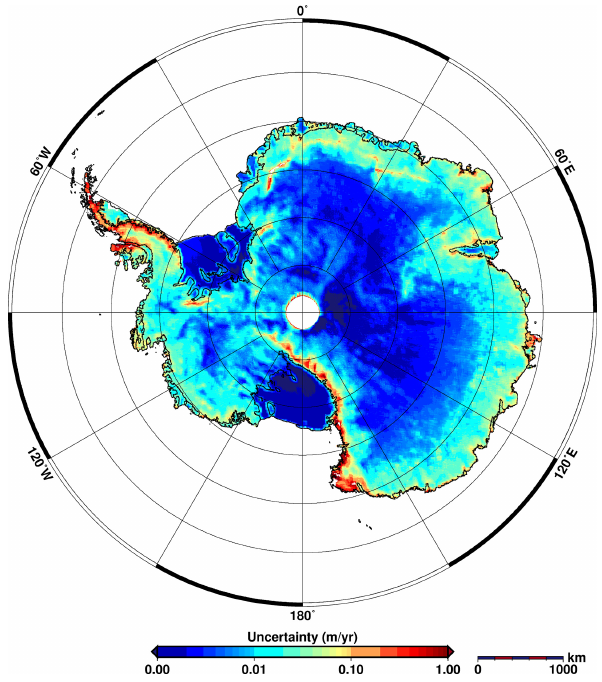
Figure A3. Uncertainty map of elevation change of Antarctica de- rived from error propagation. Clearly indicated are the high uncer- tainties at the steep margins.